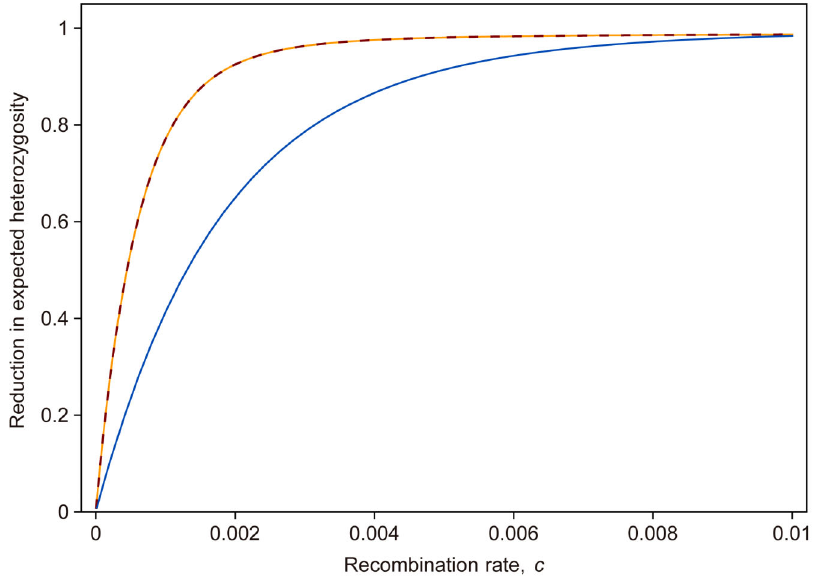
Figure 3. Reduction in expected heterozygosity at the end of selection process. Solid orange line shows the expected heterozygosity calculated from Equation (16). Dashed line is the approximated result (Equation (17)). Solid blue line demonstrates the reduction in heterozygosity according to result of Stephan et al. (1992). We assumed s ~ 0 : 02 .